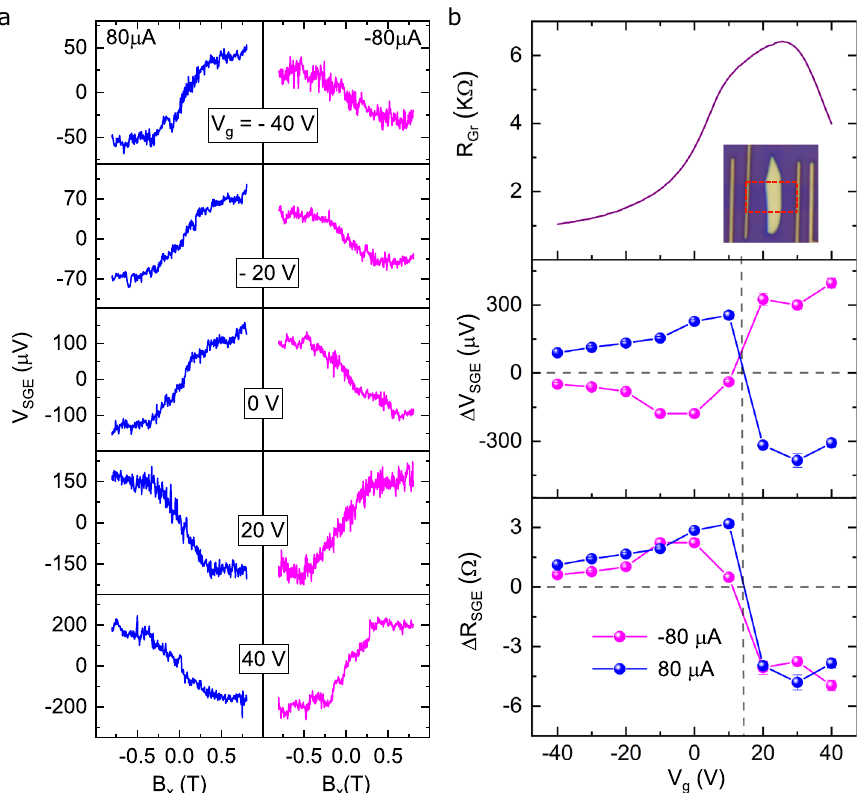
Fig. 4 Gate dependence of spin-galvanic signal in graphene-MoTe 2 heterostructure at room temperature. a Evolution of measured spin-galvanic signal ( V SGE ) by sweeping magnetic fi eld along the x-axis ( B x ) at different gate voltages in the range of + 40 to − 40 V, with I = ±80 µ A in Dev 1 at room temperature. The sign of the spin-galvanic signal changes with gate voltage V g and spin injection bias current I . b Gate dependence of graphene channel resistance ( R Gr ) and spin-galvanic signals ( Δ V SGE and Δ R SGE = Δ V SGE / I ) at I = ±80 µ A at room temperature. The sign change of the spin-galvanic signal is observed close to the charge neutrality point of graphene and the signals are of opposite sign for n and p-type regimes of the graphene-MoTe 2 heterostructure. The error bars are calculated from the noise level of the manifested signals and not clearly visible because error bars are smaller than the data